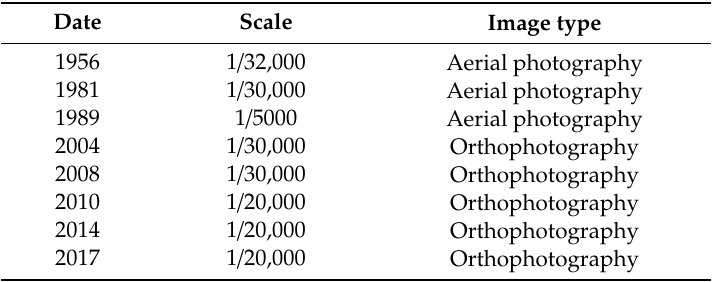
Table 1. Images used in the study with scale and image